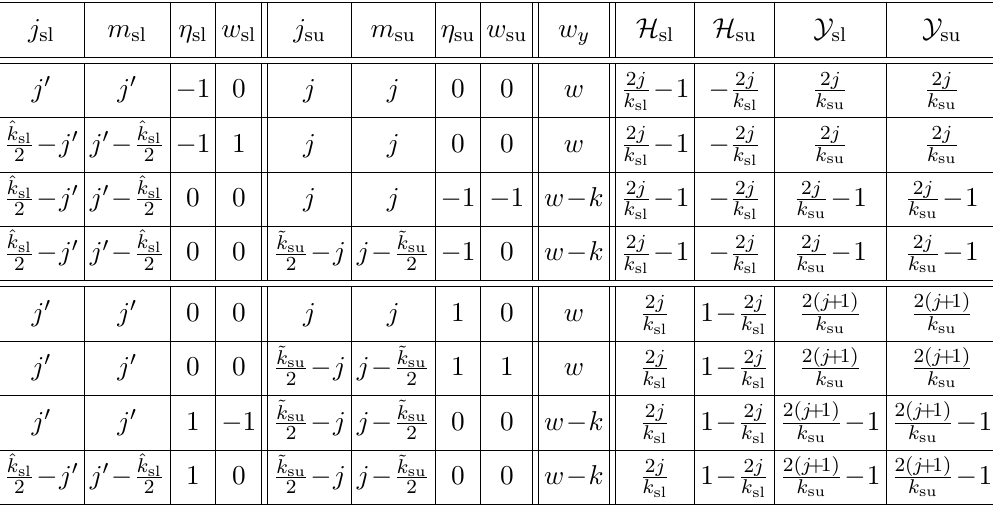
Equivalences among vertex operators. The (cid:12)rst block of four are all equivalent